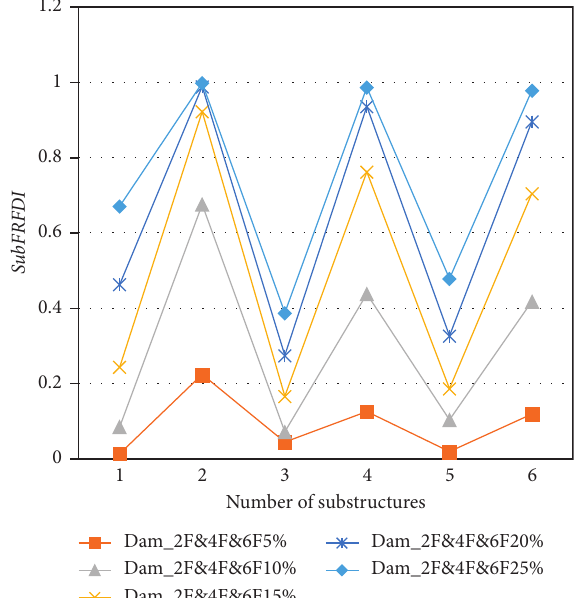
Figure 12: The comparison of the SubFRFDI for 5%, 10%, 15%, 20%, and 25% stiffness reduction in the 2 nd , the 4 th , and the 6 th